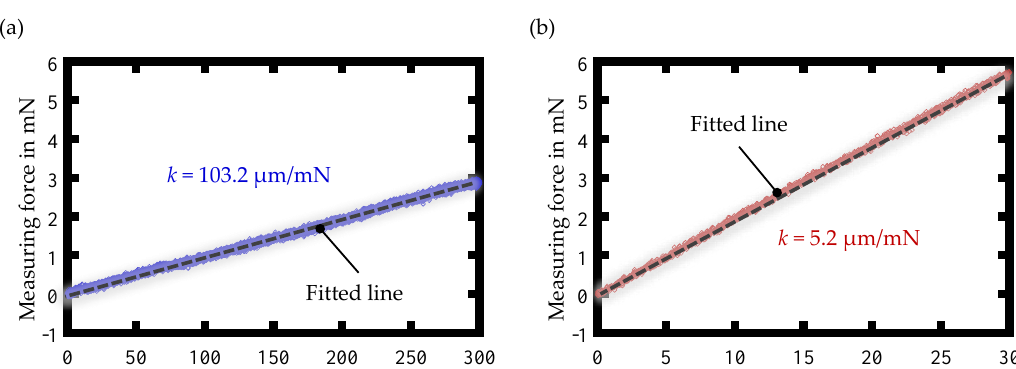
Figure 6. Evaluation results of the spring constant: ( a ) V-beam; ( b ) X-beam.